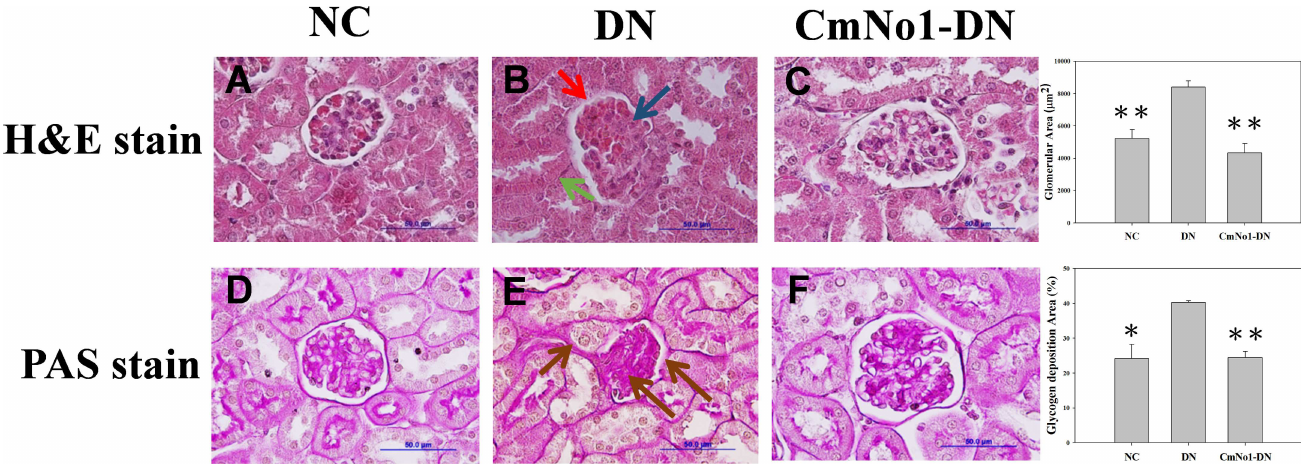
Fig 3. Effect of CmNo1 on ultrastructural alterations and glycogen accumulation. Representative microphotographs of kidney sections of NC, DN and CmNo1-DN group mice subjectedto histologicH&E (A-C, × 1000)and PAS (D-F, × 1000)stain. NC: Normal control; DN: Diabeticnephropathy; CmNo1-DN: Diabeticnephropathygroup mice treated with Cordyceps militaris No1; H&E, Hematoxylin and Eosin; PAS, PeriodicAcid–Schiff.